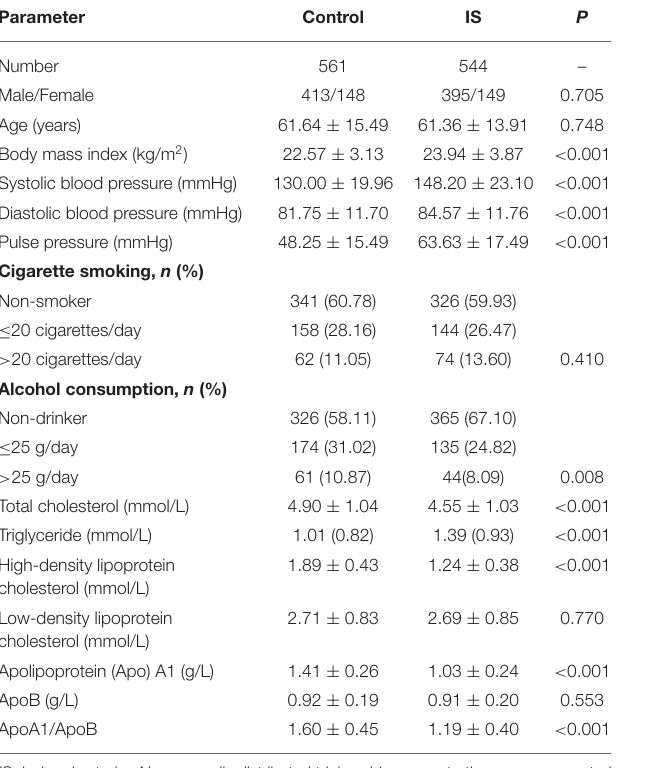
TABLE 1 | Clinical characteristics and serum lipid concentrations between control and IS groups. Parameter Control